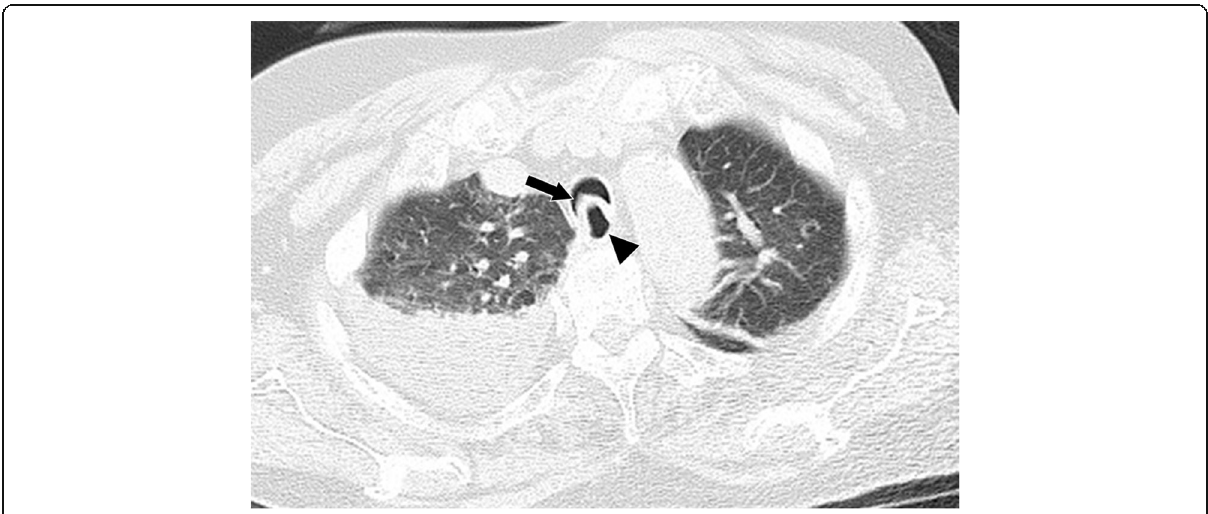
Fig. 2 Computed tomography scan of the chest. Computed tomography scan of the chest taken before surgery showing bulging of the posterior membrane (allow) into the airway lumen without collapse of the cartilage at the aortic arch level. An arrowhead indicates the